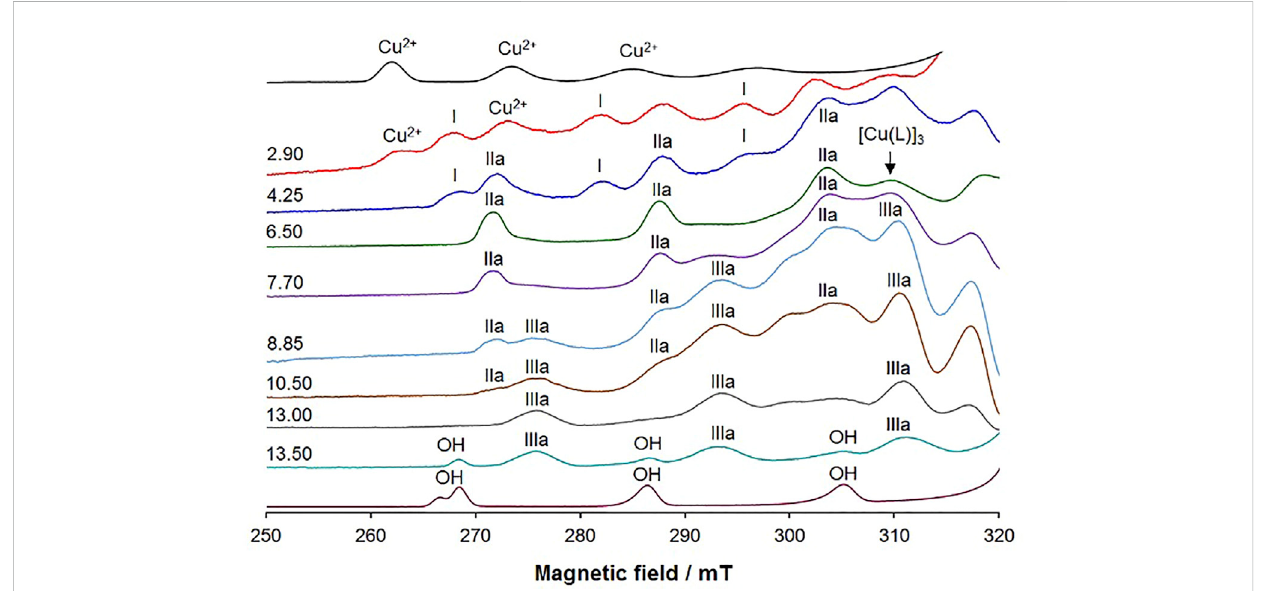
FIGURE 5 Low fi eldregionoftheX-bandanisotropic EPRspectrarecordedas afunction ofpHat120 KinamixtureDMSO/H 2 O80/20 (v/v)containing 63 Cu(II) and L 6 (molar ratio 1:1 and Cu(II) concentration 1.0 mM). The fi rst and last spectra were recorded on solutions containing the solvated and hydroxide complexes.With I areindicatedthe fi rstthreeequatorial resonancesof[Cu(LH)] + ,with IIa of[Cu(L)]withthedonorset[(O − ,N,N 2 im );H 2 O],andwith IIIa of [Cu(LH